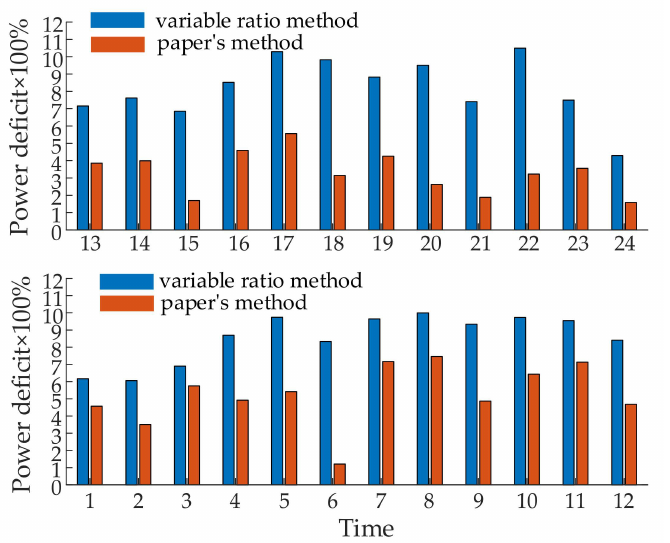
Figure 4. Dispatch power shortage of paper’s method and variable proportion method in 24